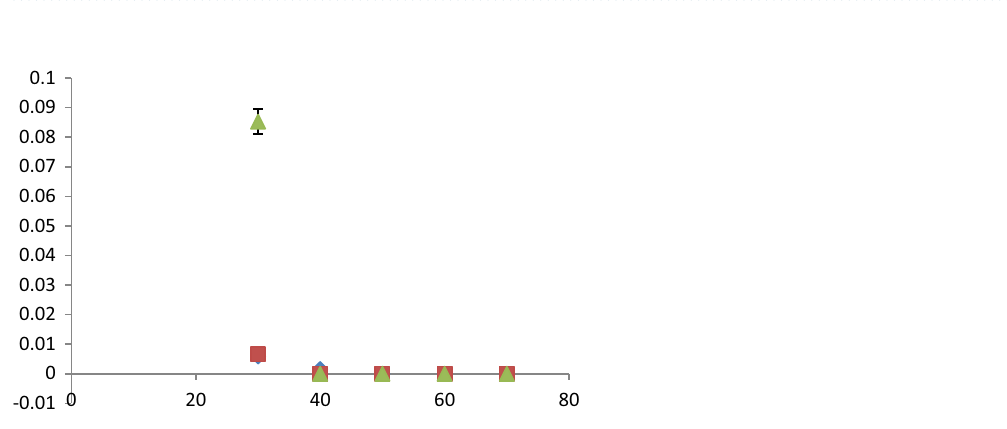
Figure 12. Adsorption isotherms for